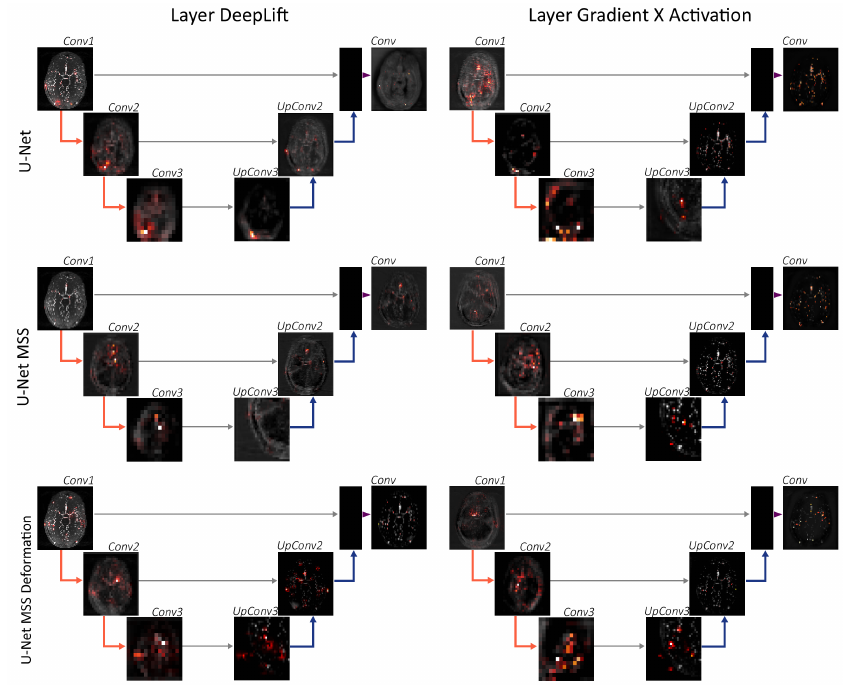
Figure 8. Layer-based interpretability methods: Layer Deeplift and Layer Gradient X Activation, shown using representative U-Nets. The higher the intensity of red, the higher the concentration of the focus of the network. This figure shows how the focus of the network changes in each layer for the three different